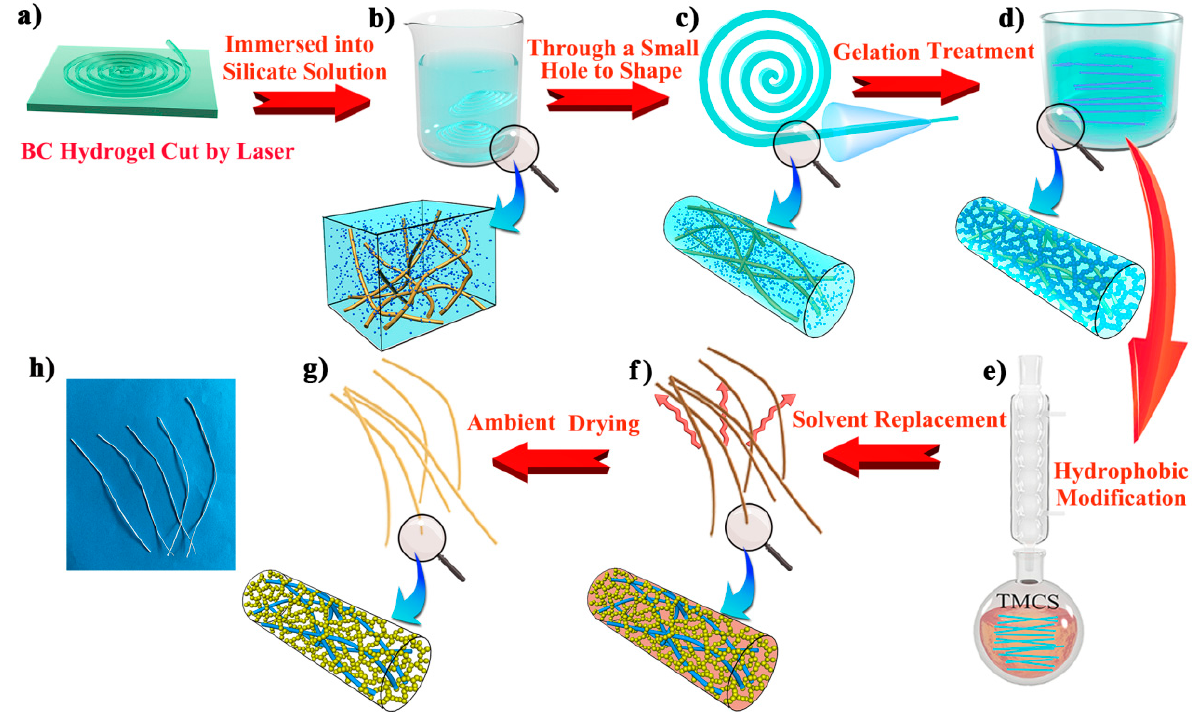
Figure 8. Schematic illustration of the preparation process of CAFs. A nata-de-coco slice was cut using a laser ( a ). The matrix was immersed in sodium silicate solution ( b ) and reshaped by a small hole mold ( c ). After the silica gel skeleton was formed in the matrix ( d ), CAFs were obtained through hydrophobic modification, solvent replacement, and ambient drying ( e – h ).